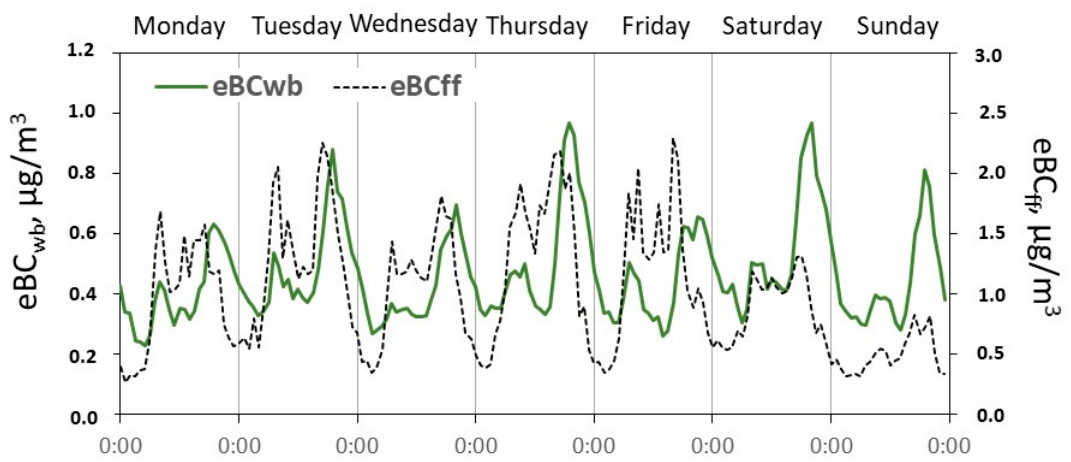
Figure 7. Mean weekly diel variations of eBC wb and eBC ff concentrations at the Poitiers urban background station during the winter season (2017–2018).